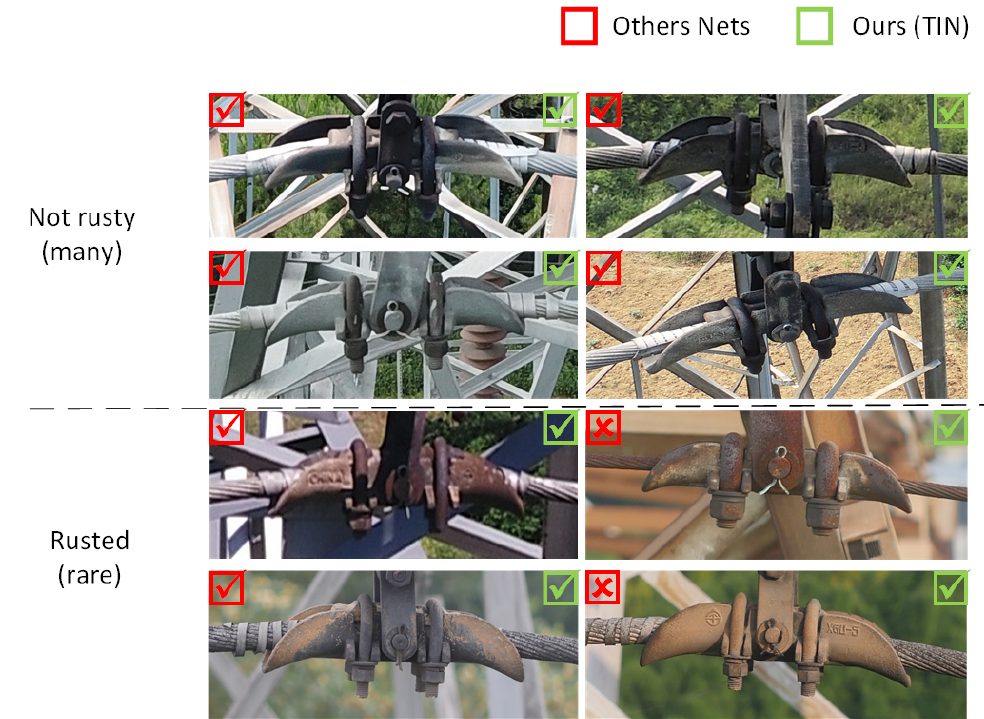
Figure 8. Results visualization: The results of the other models and our network are shown in each picture’s upper left and right corners, respectively. Our model is more robust to rare classes and can recognize pictures more